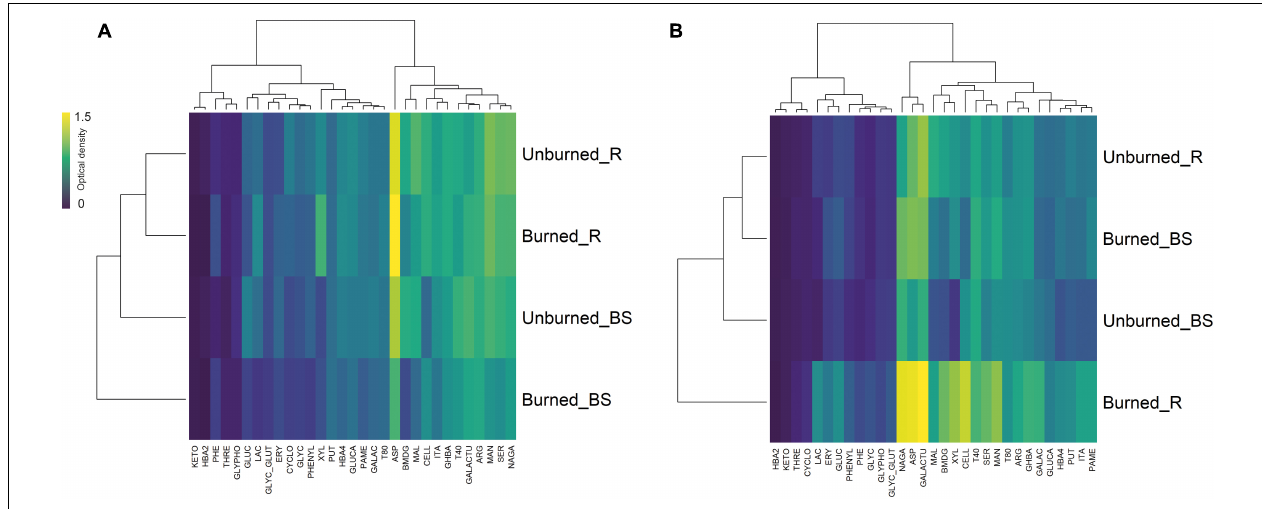
FIGURE 3 | Clustered heatmaps based on the average ( n = 3) of carbon source utilization patterns of soil microbial communities, also referred as community-level physiological profile (CLPP) for (A) Pumanque and (B) Requínoa, by treatment (burned vs. unburned) and soil compartment (R = rhizosphere; BS = bulk soil). Row dendrograms show the Euclidean distance between treatments, while column dendrograms show the distance between the utilization of C sources. Yellow boxes represent higher microbial C utilization. The following 31 different carbon sources were used: (1) carbohydrates: α - D -lactose (LAC), i-erythritol (ERY), D -xylose (XYL), β -methyl- D -glucoside (BMDG), D -cellobiose (CELL), D -mannitol (MAN), N -acetyl- D -glucosamine (NAGA); (2) carboxylic acids: 2-hydroxy-benzoic acid (2HBA), 4-hydroxy-benzoic acid (4HBA), D -glucosaminic acid (GLUCA), pyruvic acid methyl ester (PAME), α -keto-butyric acid (KETO), D -galactonic acid γ -lactone (GALAC), D -malic acid (MAL), itaconic acid (ITA), γ -hydroxy-butyric acid (GHBA), D -galacturonic acid (GALACTU); (3) amino acids: L -threonine (THRE), L -phenylalanine (PHE), glycyl- L -glutamic acid (GLYC), L -asparagine (ASP), L -arginine (ARG), L -serine (SER); (4) polymers: α -cyclodextrin (CYCLO), glycogen (GLYC), Tween 80 (T80), Tween 40 (T40); (5) miscellaneous: D , L - α -glycerol-phosphate (GLYPHO), glucose-1-phosphate (GLUC); and (6) amines/amides: phenylethylamine (PHE), putrescine